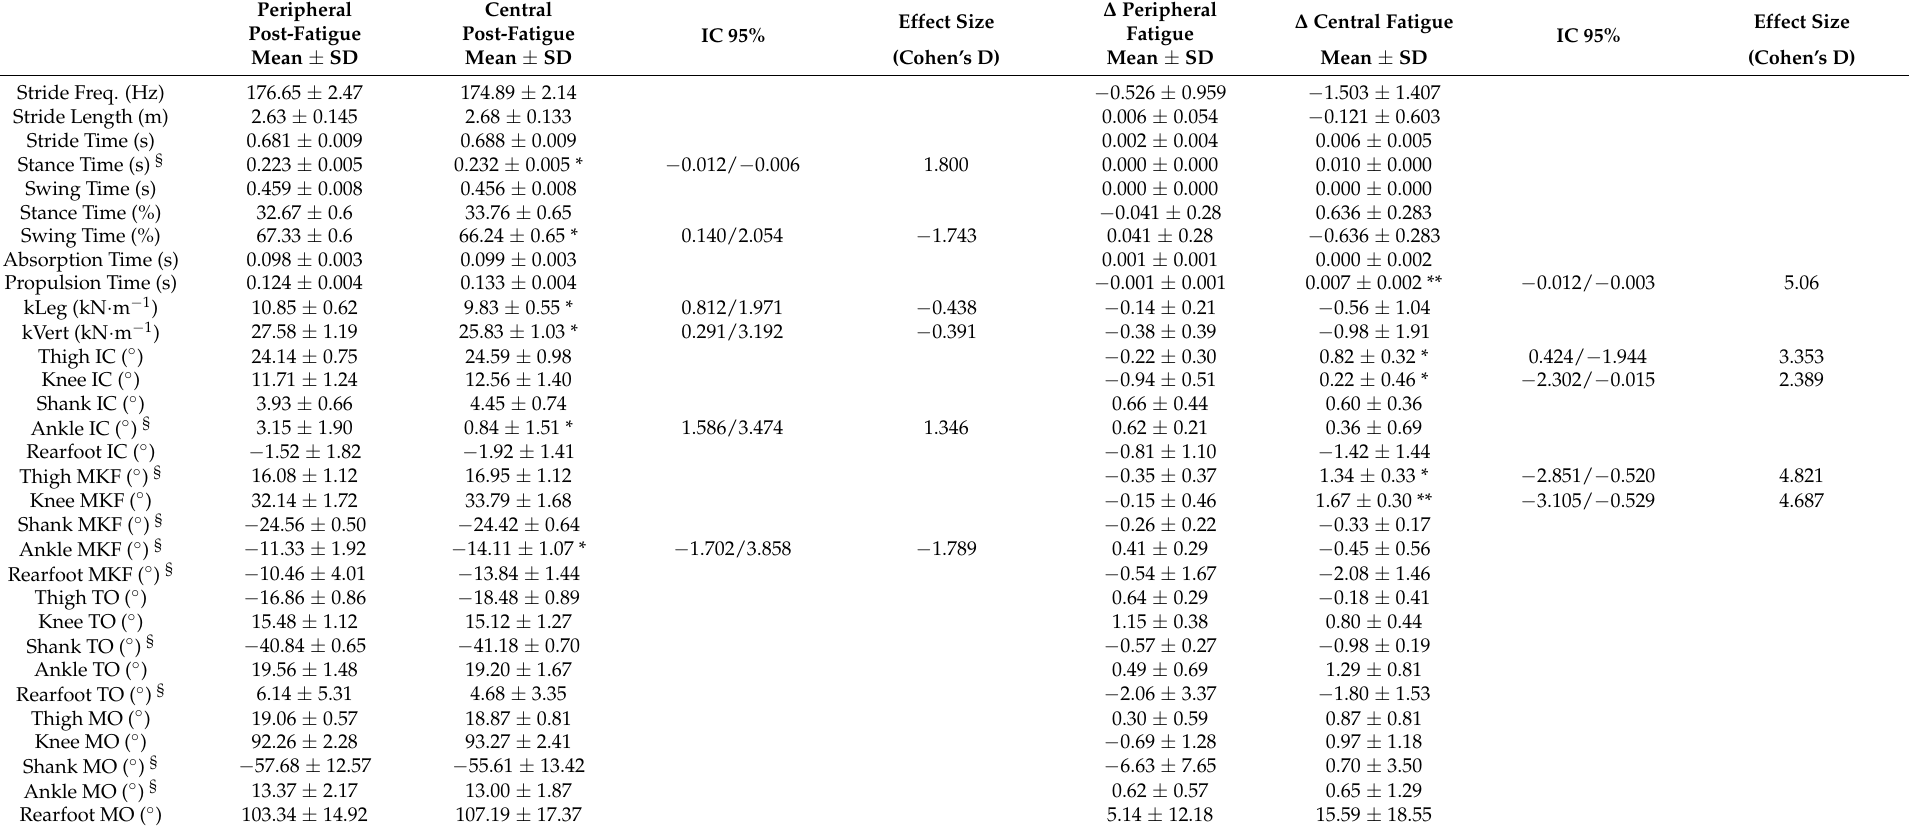
Table 3. Comparison of kinematics modifications after central vs. peripheral